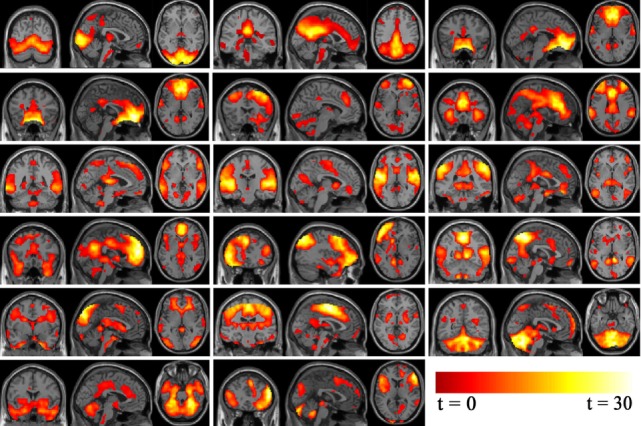
Independent component analysis non-noise resting state networks from left to right (top row: occipital/temporal, posterior default mode, Visual. Second row: orbitofrontal, right frontoparietal, anterior default mode. Third row: frontotemporal, temporal, parietal. Fourth row: medial frontal/anterior cingulated, left frontoparietal, occipital/parietal. Fifth row: occipital/temporal/cerebellum, frontotemporal/paralimbic, frontotemporal/cerebellum. Bottom row: cerebellum/midbrain, temporal/limbic.).